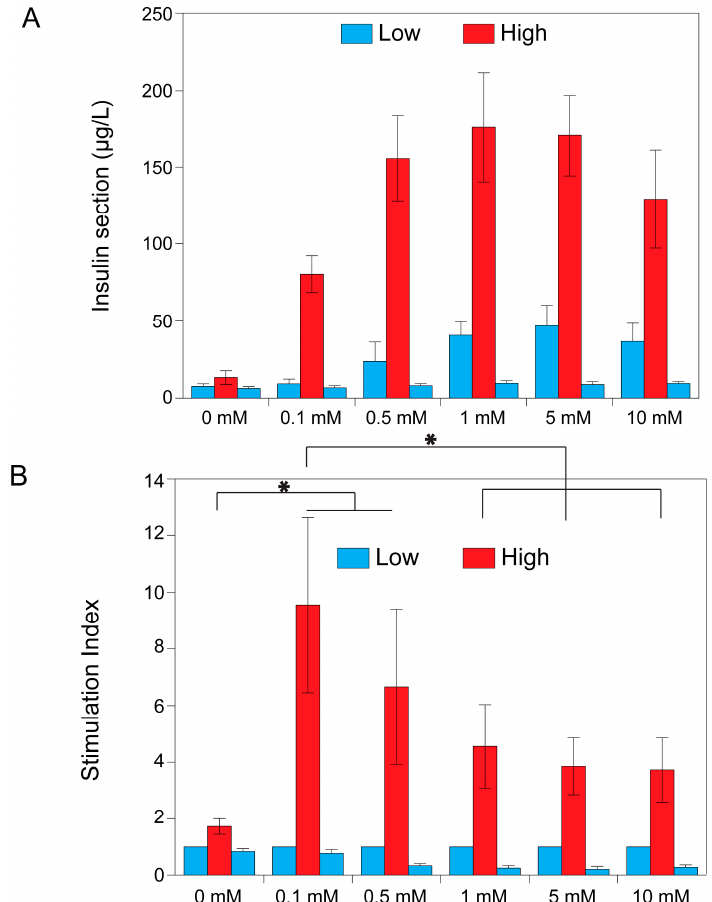
Figure 3. Theophylline concentration-dependent insulin secretion of MIN6 pseudo-islets. Dose-response results of the glucose-induced insulin secretion test on MIN6 pseudo-islets at different concentrations of theophylline. ( A ) Secreted amount of insulin (µg/L) is shown; in ( B ) data are normalized by the amount of insulin secreted in low glucose condition (stimulation index). Data are expressed as mean ± standard deviation and significant differences are indicated with * ( p ≤ 0.05). Statistical analysis compares the stimulation indices in high glucose conditions.